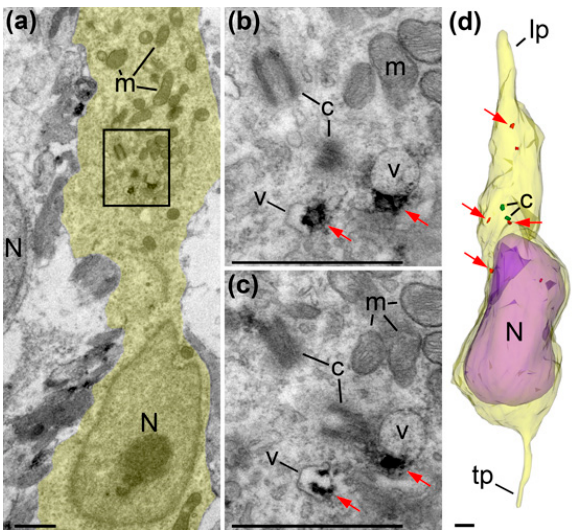
Figure 8. Electron micrographs and 3D reconstruction of a cell radially migrating through IZ of E16 mouse (also shown in Figure 10 as cell M11). The images are placed with the pia-directed segment up and the segment facing ventricular surface down. Cell body and proximal segments of truncated leading (lp) and trailing processes (tp) are shown as semitransparent yellow, and the nucleus (N) is semitransparent violet. Framed area in ( a ) is enlarged in ( b ) and further followed in serial image ( c ). Notice both centrioles (c; depicted green in ( d )) located basally relative to the nucleus (N). Anti-CB 1 R-L31 immunoreaction DAB-Ni end-products are shown red and pointed with red arrows. Although CB 1 R is not abundant in this cell, its characteristic location on the outer surface of intracellular vesicles (v) proves selective immunolabeling. Abbreviation: m, mitochondria. Scale bars: 1 µ m. Int. J. Mol. Sci. 2020 , 21 , x FOR PEER REVIEW